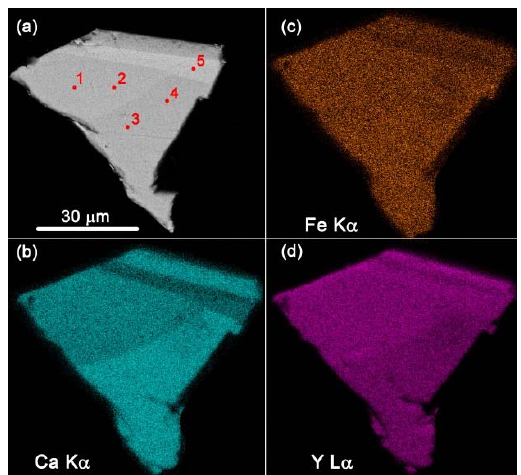
Figure 2. Back ‐ scatter electron detector (BSE) image, analyzed by WDX spots (1–5) and elemental maps (EDX), of studied crystals: ( a ) BSE image, ( b ) FeK α elemental map, ( с ) CaK α elemental map, ( d ) YL α elemental map.